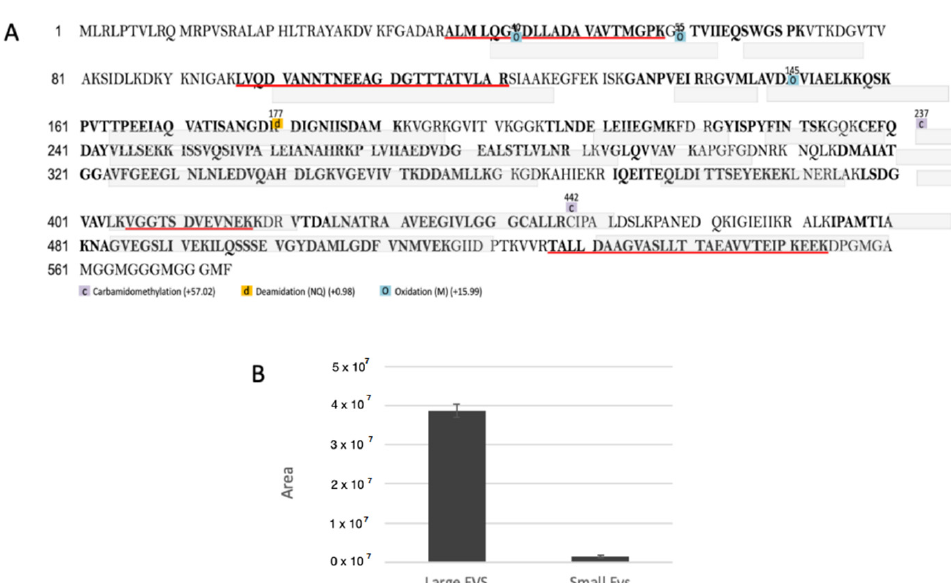
Figure 7. ( A ) Sequence coverage map of Hsp60 (UniProt accession no., P63038) obtained by tryptic digestion and nUHPLC/HR nESI-MS/MS. Peptides identified in the extracellular vesicle (EV) samples are shown in bold; peptides identified in the small EVs sample are underlined. ( B ) Quantification of Hsp60 levels between large and small EVs.